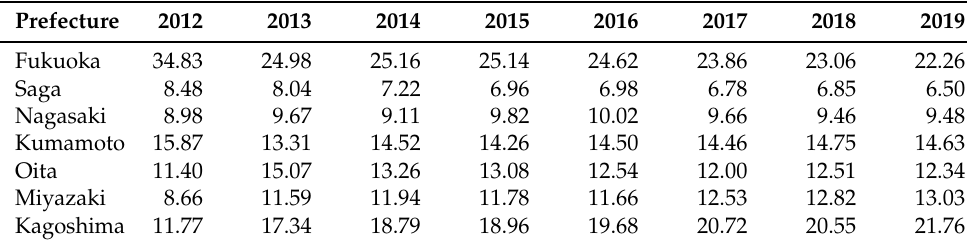
Table 2. Share of solar power installations (%) in the prefectures.